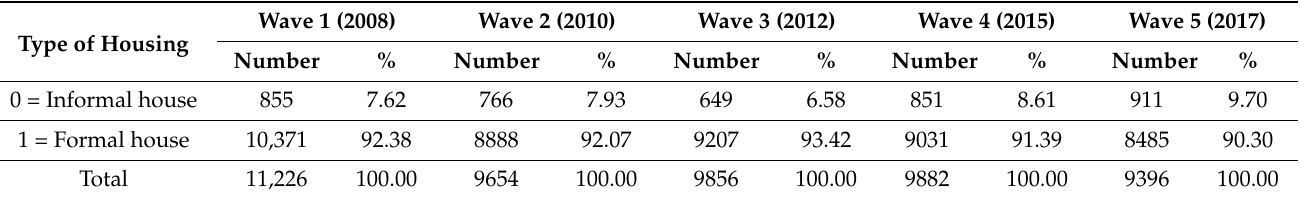
Table 1. Housing conditions and numbers of people aged 0 to 17 in NIDS Wave